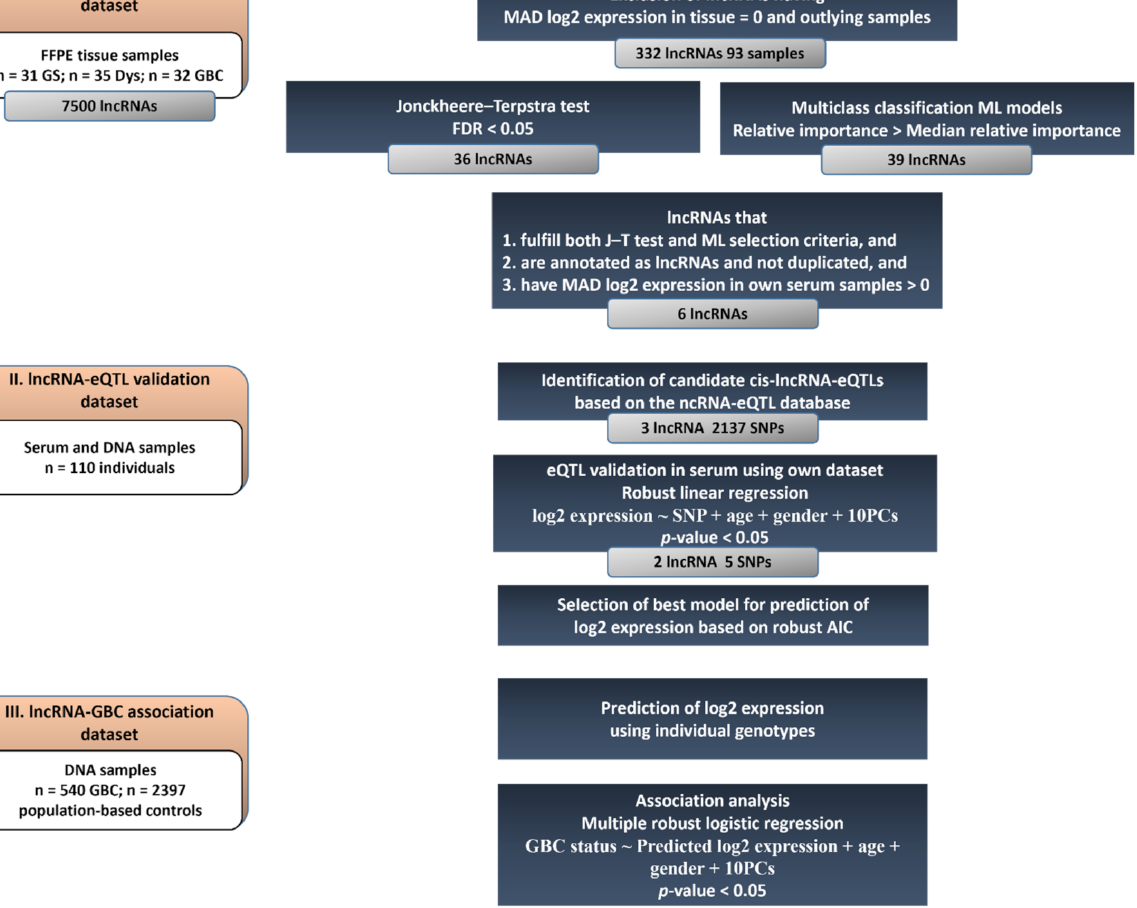
Figure 1. Flowchart representing the three-stage approach used in the